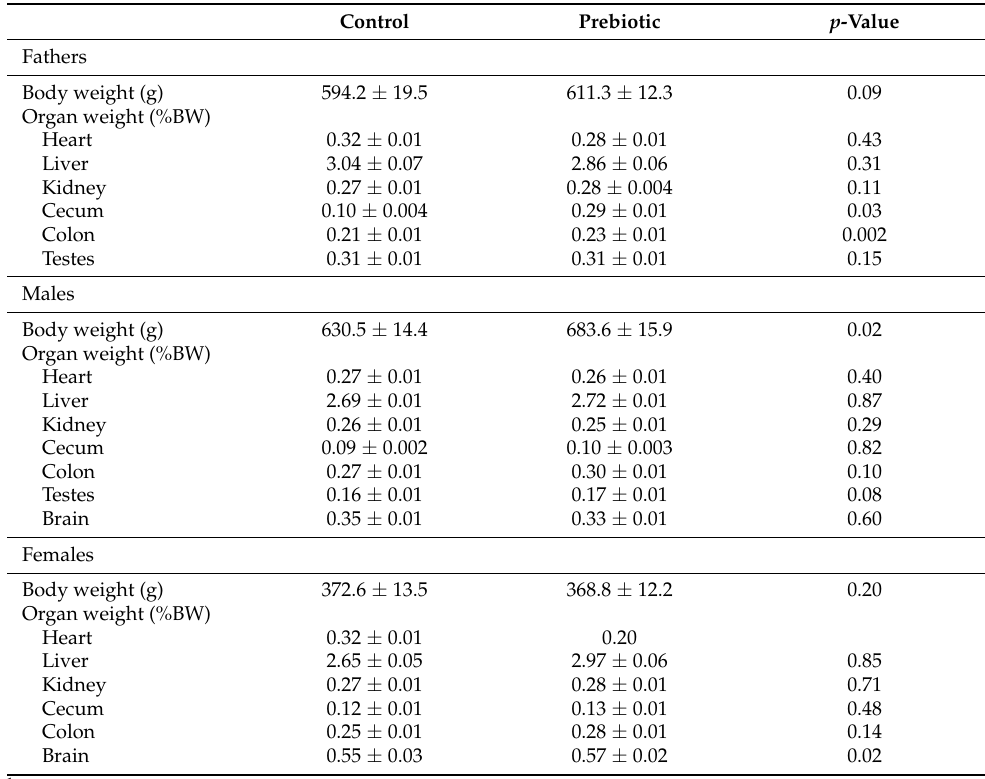
Table 3. Organ weight of fathers at 12 weeks of age and offspring at 16 weeks of age 1 . Control Prebiotic p